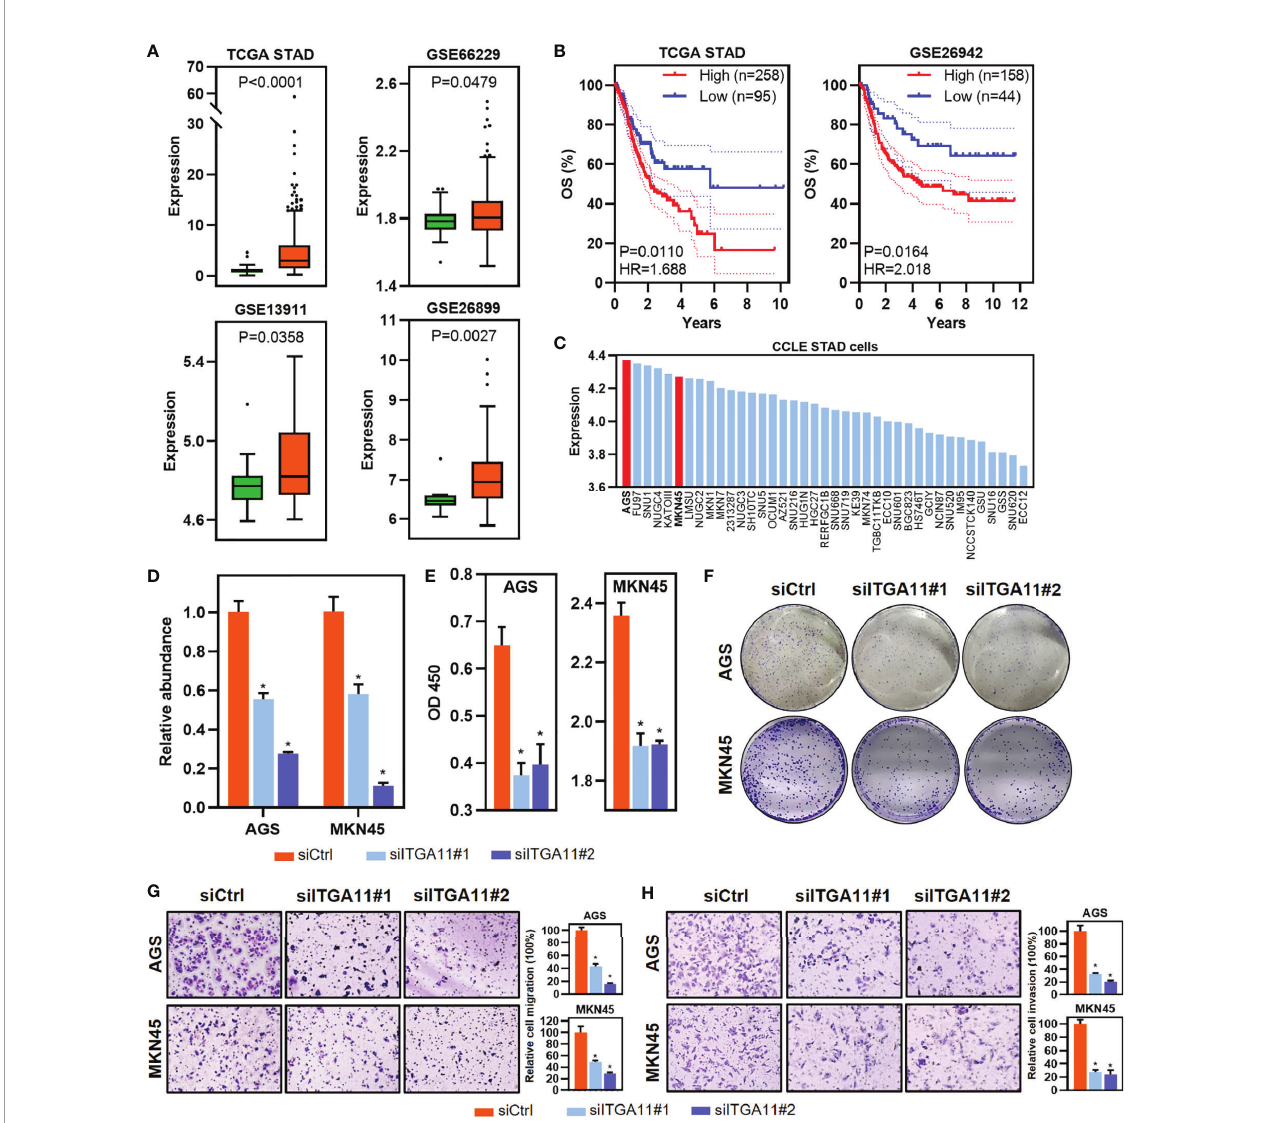
FIGURE 5 | Identi fi cation and functional validation of ITGA11 in STAD. (A) Boxplot of ITGA11 expression in tumor and normal samples of STAD from the TCGA and GEO datasets. P values of boxplots are based on the Mann – Whitney test. (B) Kaplan – Meier plot showing 5-year OS and PFS with the expression of ITGA11 in STAD samples from the TCGA and GEO datasets. (C) Barplot showing the expression of ITGA11 in STAD cell lines. (D) Relative abundance of ITGA11 levels were detected in AGS and MKN45 by qRT-PCR after transfected siRNAs. Data are shown as means ± SEM. P values of barplots are based on the Mann – Whitney test. (E, F) The effects of ITGA11 on proliferation (E) and colony formation (F) in AGS and MKN45 cell lines. Data are shown as means ± SEM. P values of barplots are based on the Mann – Whitney test. (G, H) Cell migration (G) and invasion (H) were detected by transwell assays. Data are shown as means ± SEM. P values of barplots are based on the Mann – Whitney test. * P <